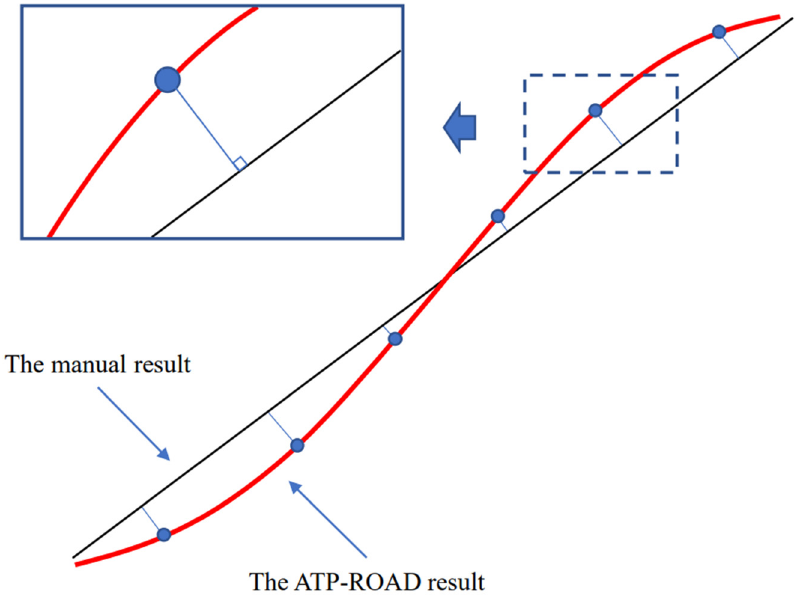
Figure 6. The distance between a road extracted by ATP-ROAD and a road by manual extraction.